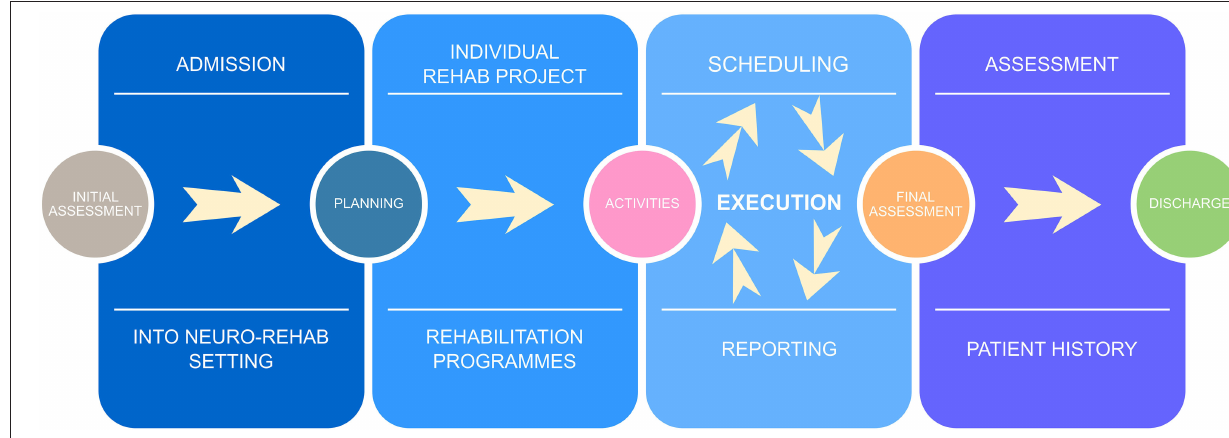
FIGURE 1 | Key steps of the rehabilitation treatment.